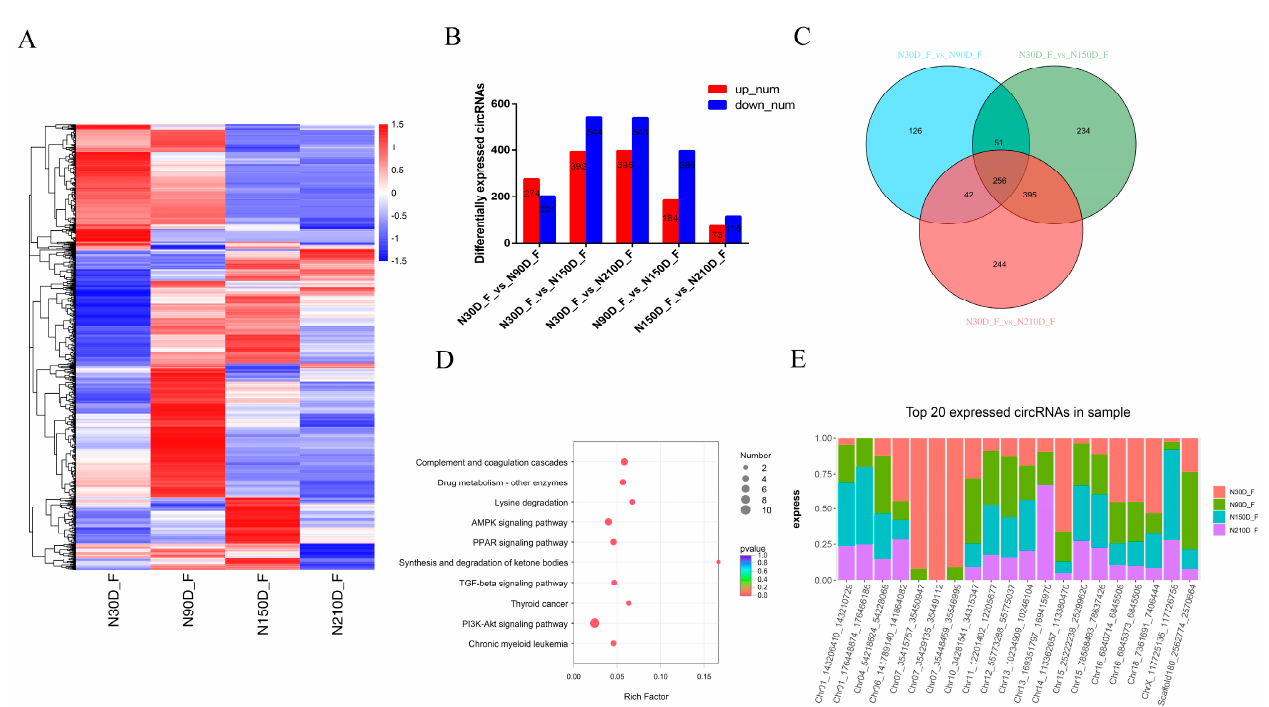
Figure 3. Differentially expressed (DE) circRNAs and their expression modes in subcutaneous fat. ( A ) Heat map of all DE circRNAs among the five compared groups (30 d vs. 90 d, 30 d vs. 150 d, 30 d vs. 210 d, 90 d vs. 150 d, and 150 d vs. 210 d groups). ( B ) Number of differentially expressed circRNAs in subcutaneous fat. vs. means versus. ( C ) The number of common DE circRNAs in subcutaneous fat. ( D ) KEGG pathway analysis of common DE genes in subcutaneous fat. The top 10 enriched KEGG pathways ranked by p -values are shown. ( E ) Top circRNAs expressed in subcutaneous fat.